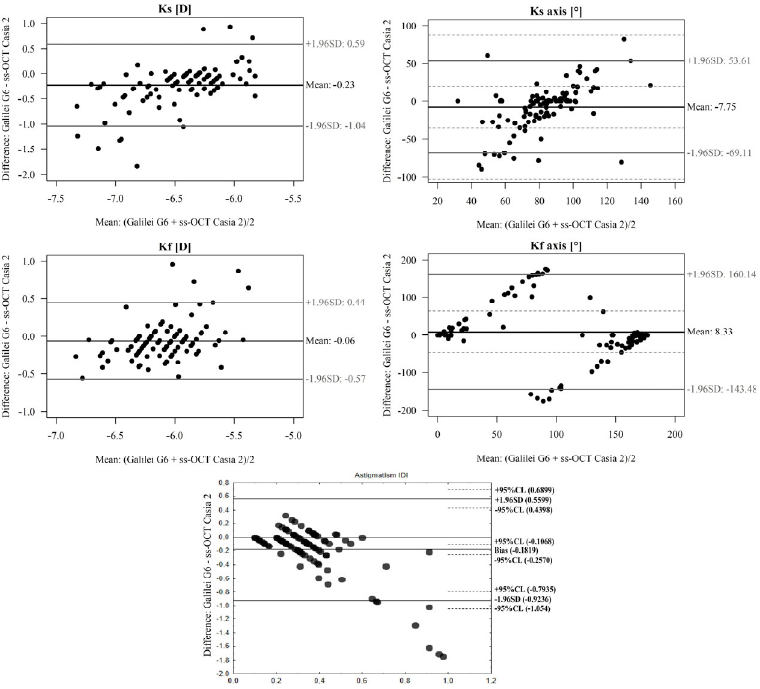
Figure 3. A Bland–Altman plot showing the agreement of posterior Ks (D), Kf (D), Kf axis ( ◦ ), Ks axis ( ◦ ), and posterior astigmatism As. (D) measurements between the OCT Casia 2 and GalileiG6 Dual Scheimpflug Analyzer. The line shows the mean difference, and the top and bottom dashed lines show the upper and lower 95% LoA, respectively.